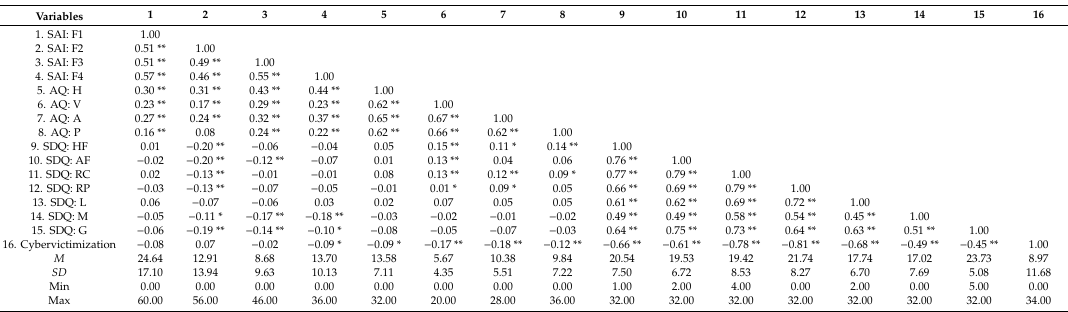
Table 1. Descriptive analyses and correlations of SAI, SDQ-I, AQ, and cybervictimization.